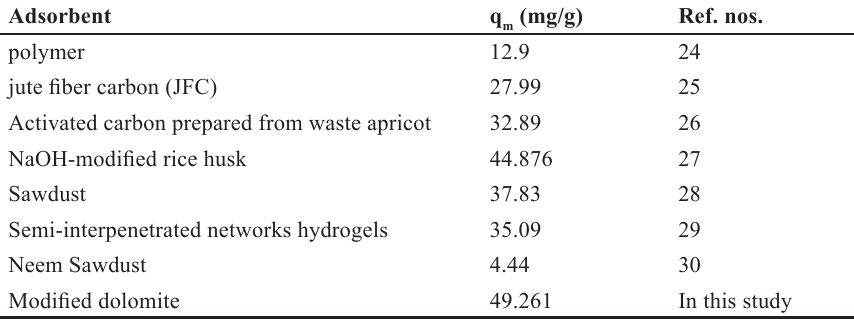
Table 4. Adsorption results of CV+ from the literature by various